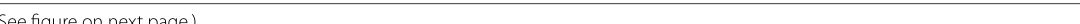
μm(See figure on next Fig. 3 Characteristic of RHLC and collagen sponge samples. a Circular dichroism (CD) spectra recorded at a wavelength of 190–260 nm. A significant negative peak at 198 nm indicating a triple helical structure. b DSC analysis of the thermal denaturation temperature of freeze-dried samples were heated from 40 °C to 200 °C at a rate of 5 °C/min. c Fourier transform infrared spectroscopy (FTIR) analysis at a wavelength range of 650–4000 cm-1 under ATR mode. d XRD analysis with the 2θ scanning range was from 5° to 80° with a scan speed of 5° per min. The collagen sponge has a lower 20° (2θ) peak, indicating slight degradation of the triple helical structure. e – j SEM analysis of freeze-dried RCHL and collagen sponge samples. The three adjacent panels represent the same samples. e Freeze-dried RHLC. f SEM image at a scale plate of 500 μm. g SEM image at a scale plate of 100 μm. h Freeze-dried collagen sponge. i SEM image at a scale plate of 500 μm. j SEM image at a scale plate of 100